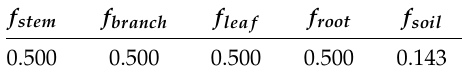
Table A3. Biomass carbon fraction parameters.